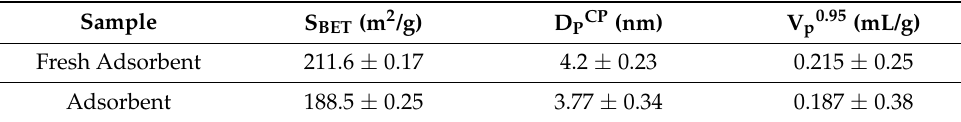
Figure 4. PSD curve of: ( a ) fresh adsorbent; ( b ) adsorbent. Table 3. BET surface area and pore dimensions of fresh and